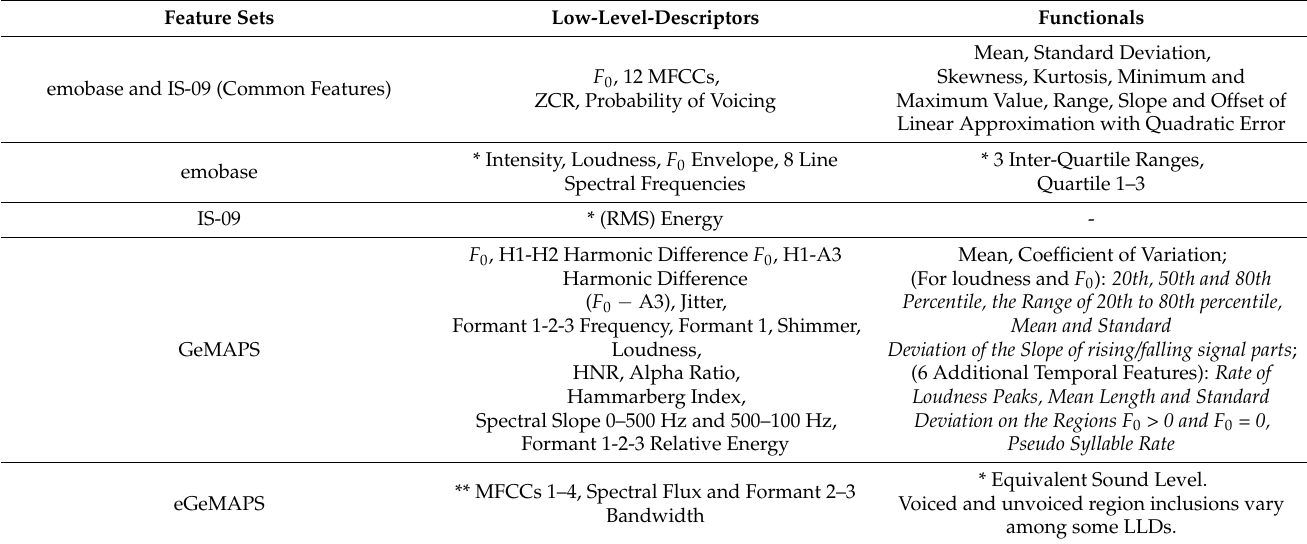
Table 2. Low-Level-Descriptors and Functionals of Each Feature Set. (*) indicates features of emobase and IS-09 distinct from each other. (**) indicates the features of eGeMAPS in addition to GeMAPS